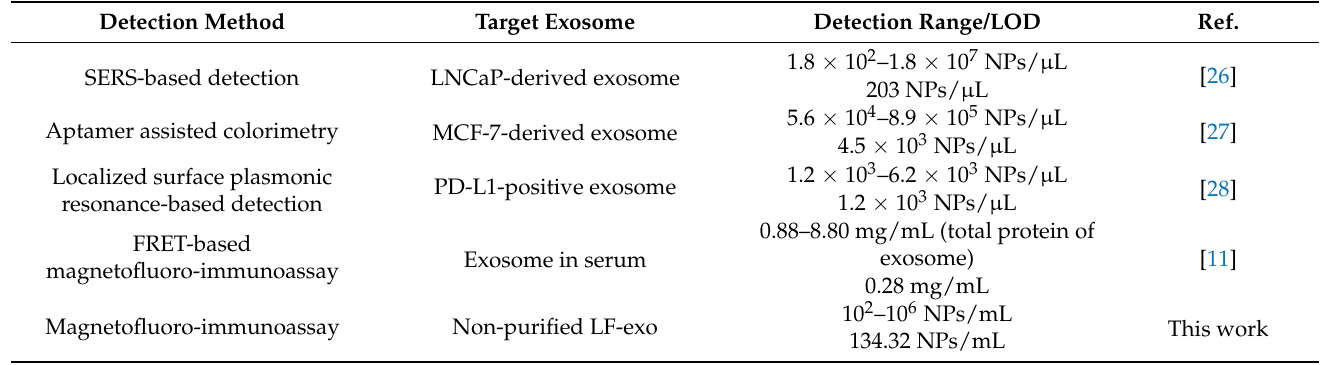
Table 1. Comparison of recent research into exosome detection via various detection